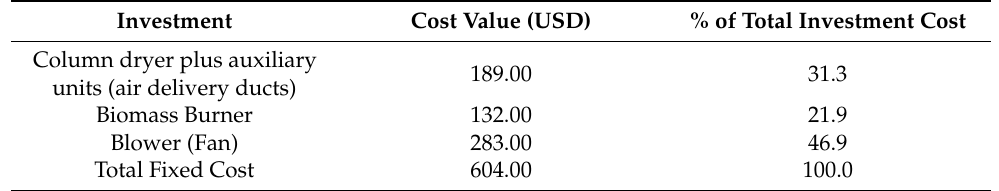
Table 3. Capital cost of the drying